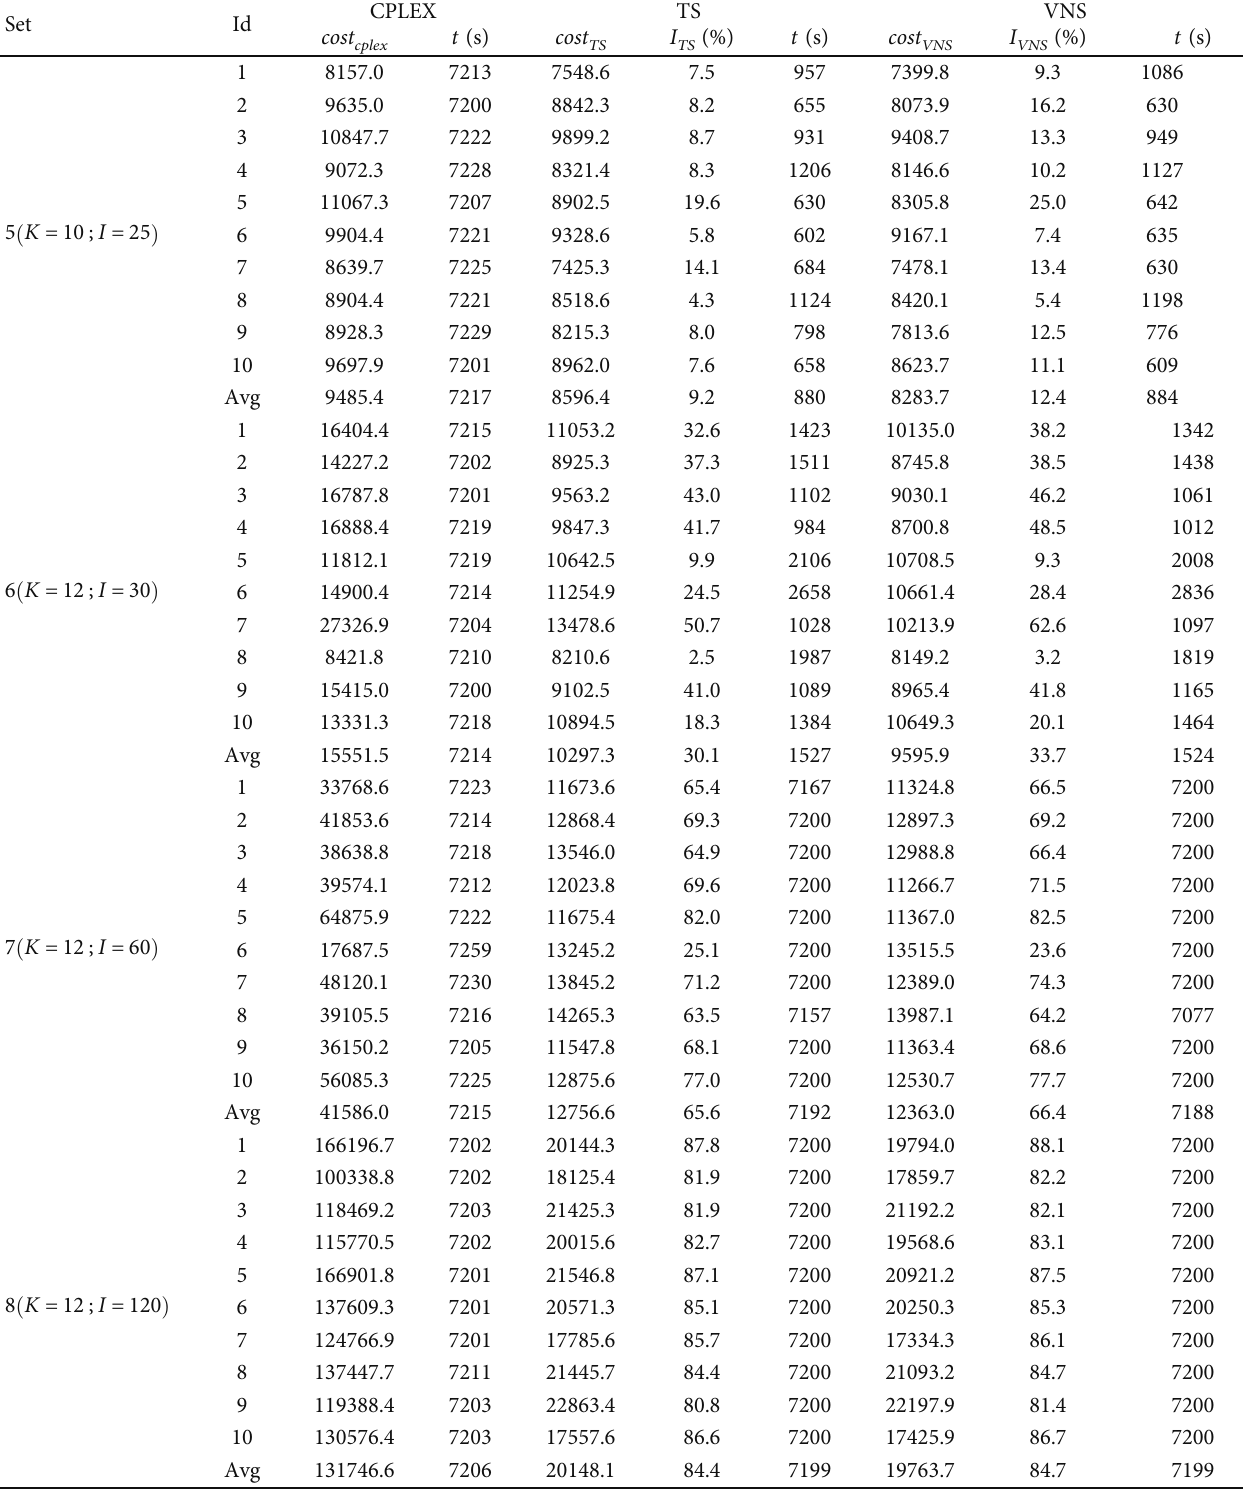
Table 2: Results on randomly generated large-sized